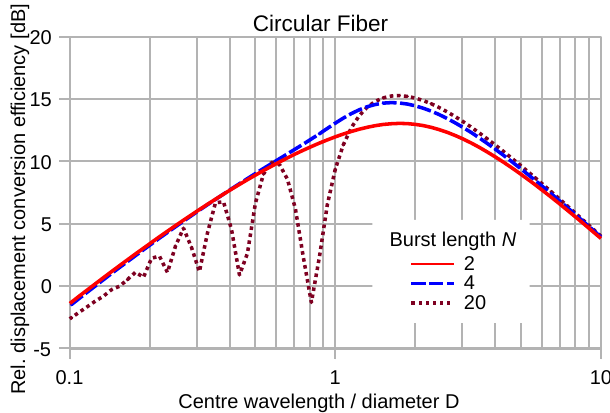
Figure 15. Normalized energy conversion of various sine-burst pulses by a circular fiber segment as a function of λ M / D . The wave displacement magnitude is kept